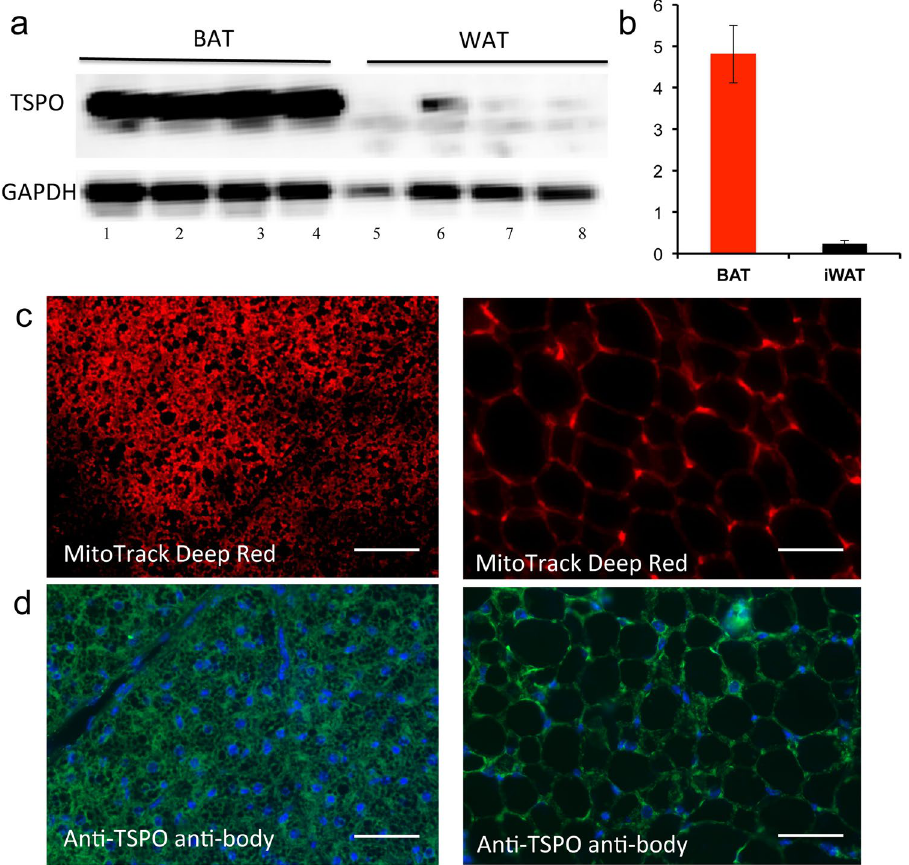
Figure 4. Biological validation of high expression level of TSPO in BAT. ( a ) Western blot of BAT and WAT tissue extractions with anti-TSPO antibody (lane1–4: four duplicated BAT samples; lane5–8: four duplicated WAT samples), and the full length of blot could be found in SI Fig. 6b, ( b ) quantification of ( a ). Note higher TSPO level in BAT compared to WAT. ( c ) Histological staining of BAT (left) and WAT (right) tissue slices with mitochondria specific dye MitoTrack deep Red, and ( d ) immunohistological staining of BAT and WAT tissue with anti-TSPO antibody (green) and DAPI for nuclei (blue). Scale bar: 30 μ